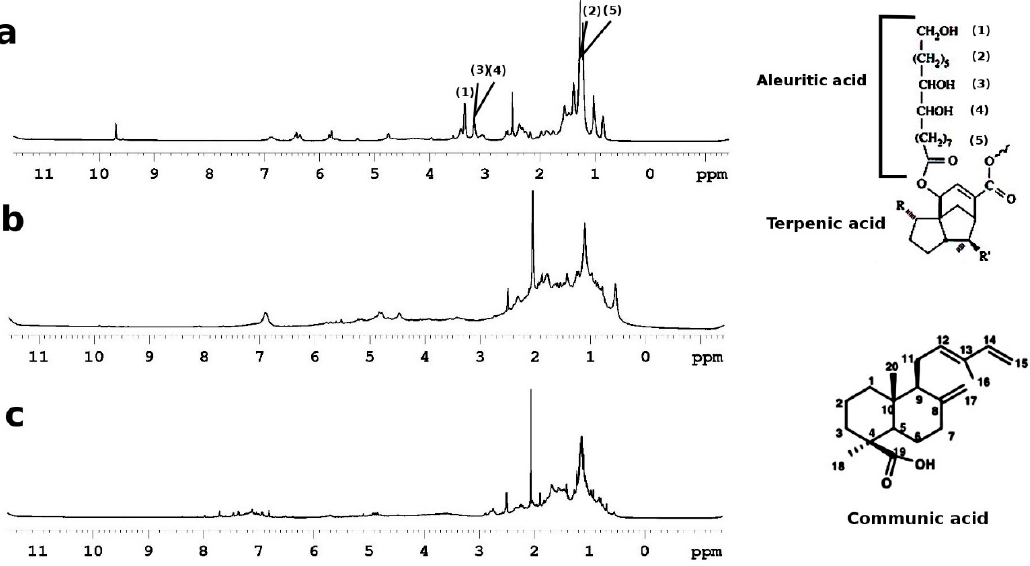
Figure 6. 1 H HR-MAS spectroscopy spectra: ( a ) shellac; ( b ) sandarac and ( c ) colophony resin in d6-DMSO ( δ = 2.55 ppm).